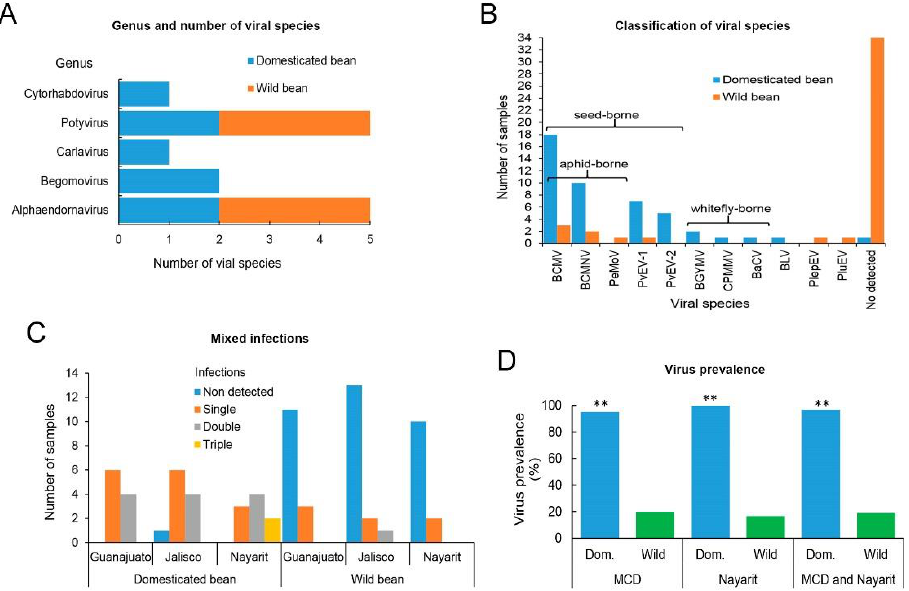
Figure 3. Virus detection, mixed infections, and prevalence of viruses in domesticated and wild Phaseolus spp. samples from Phaseolus spp. samples from the Mesoamerican center of domestication of common bean (Jalisco the Mesoamerican center of domestication of common bean (Jalisco and Guanajuato States) and Nayarit, Mexico. ( A ) Genus and number of viral species detected in domesticated and wild bean in the MCD and Nayarit. ( B ) The classification of viral species detected by their mechanism of transmission, number of samples, and host (domesticated and wild bean). ( C ) A summary of samples organized by the number of detected viruses per sample and region. ( D ) Virus prevalence associated with domesticated (Dom.) and wild bean (Wild) in the MCD and Nayarit. Significant differences in virus prevalence are indicated by ** = p -value <